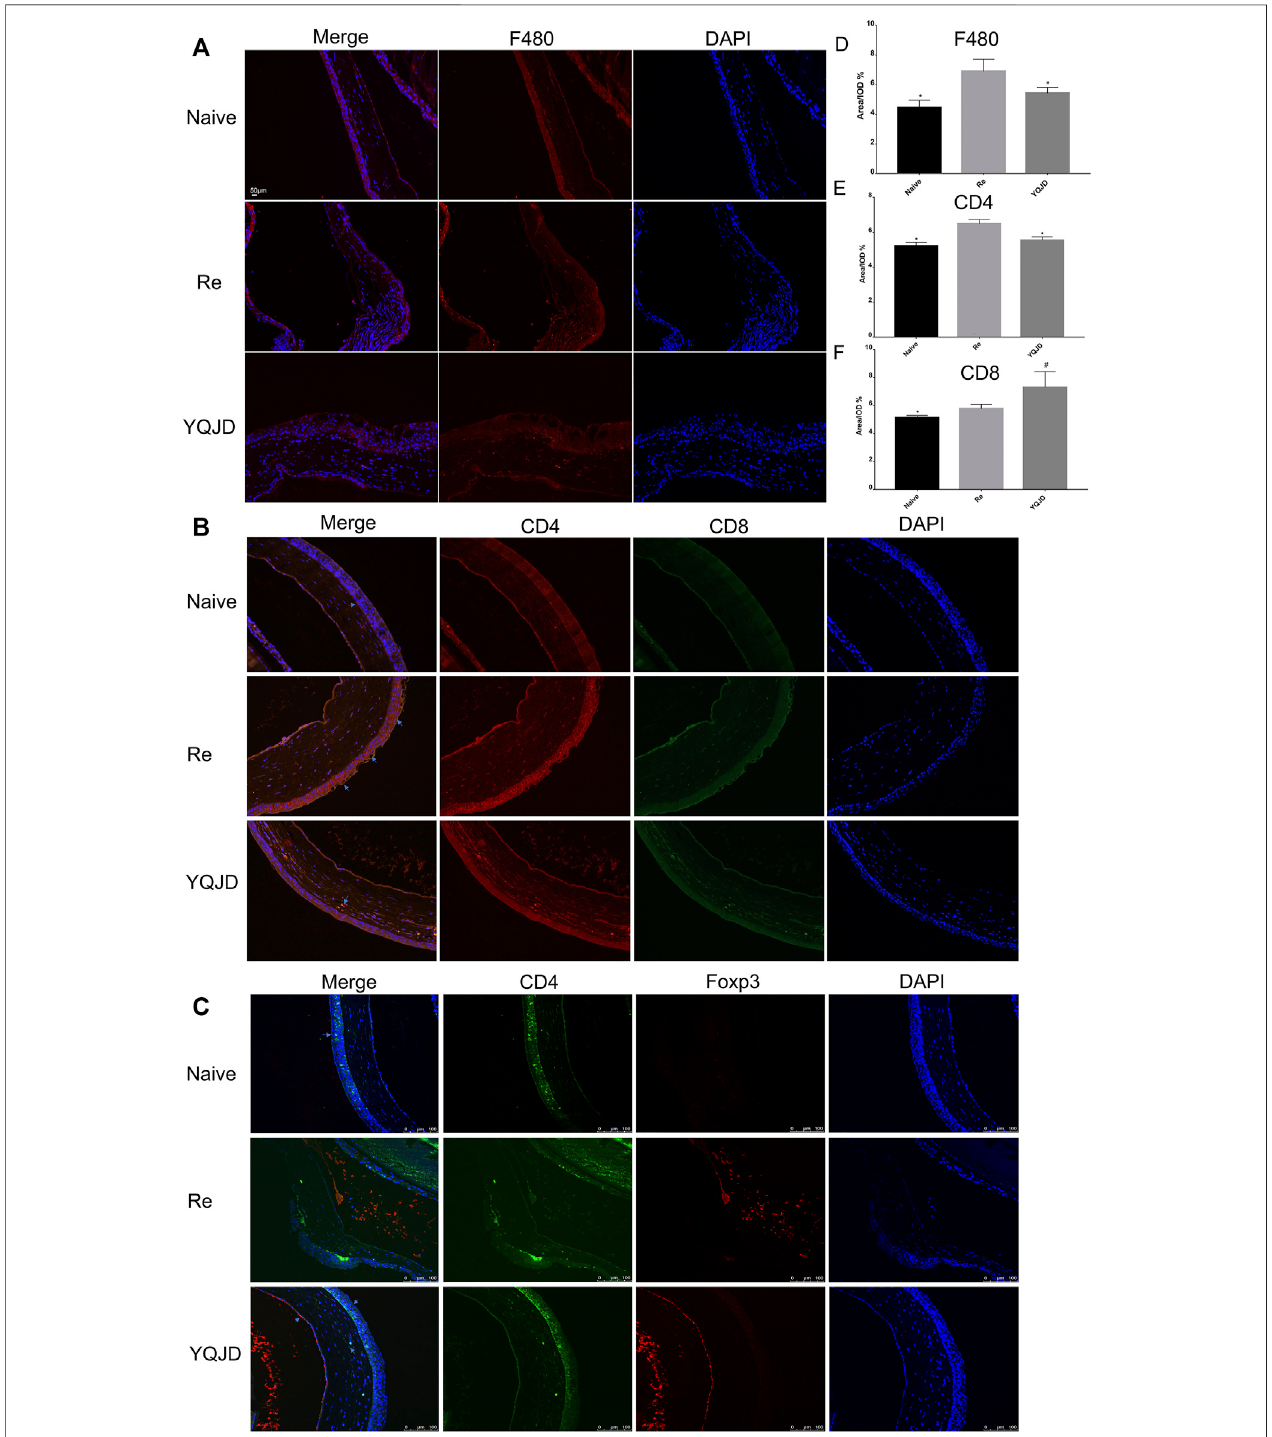
FIGURE 2 | Effects of YQJD treatment on the expression of F480, CD4, and CD8 in the cornea. (A) Expression of F480. (B) Expression of CD4 (red) and CD8 (green). (C) Expression of CD4 (green) and Foxp3 (red). (D) Statistical analysis of F480 expression. (E) Statistical analysis of CD4 expression. (F) Statistical analysis of CD8 expression. The data are expressed as the mean ± SD of three independent experiments. * p < 0.05 vs. the Re group; # p < 0.05 vs. the Naive group.